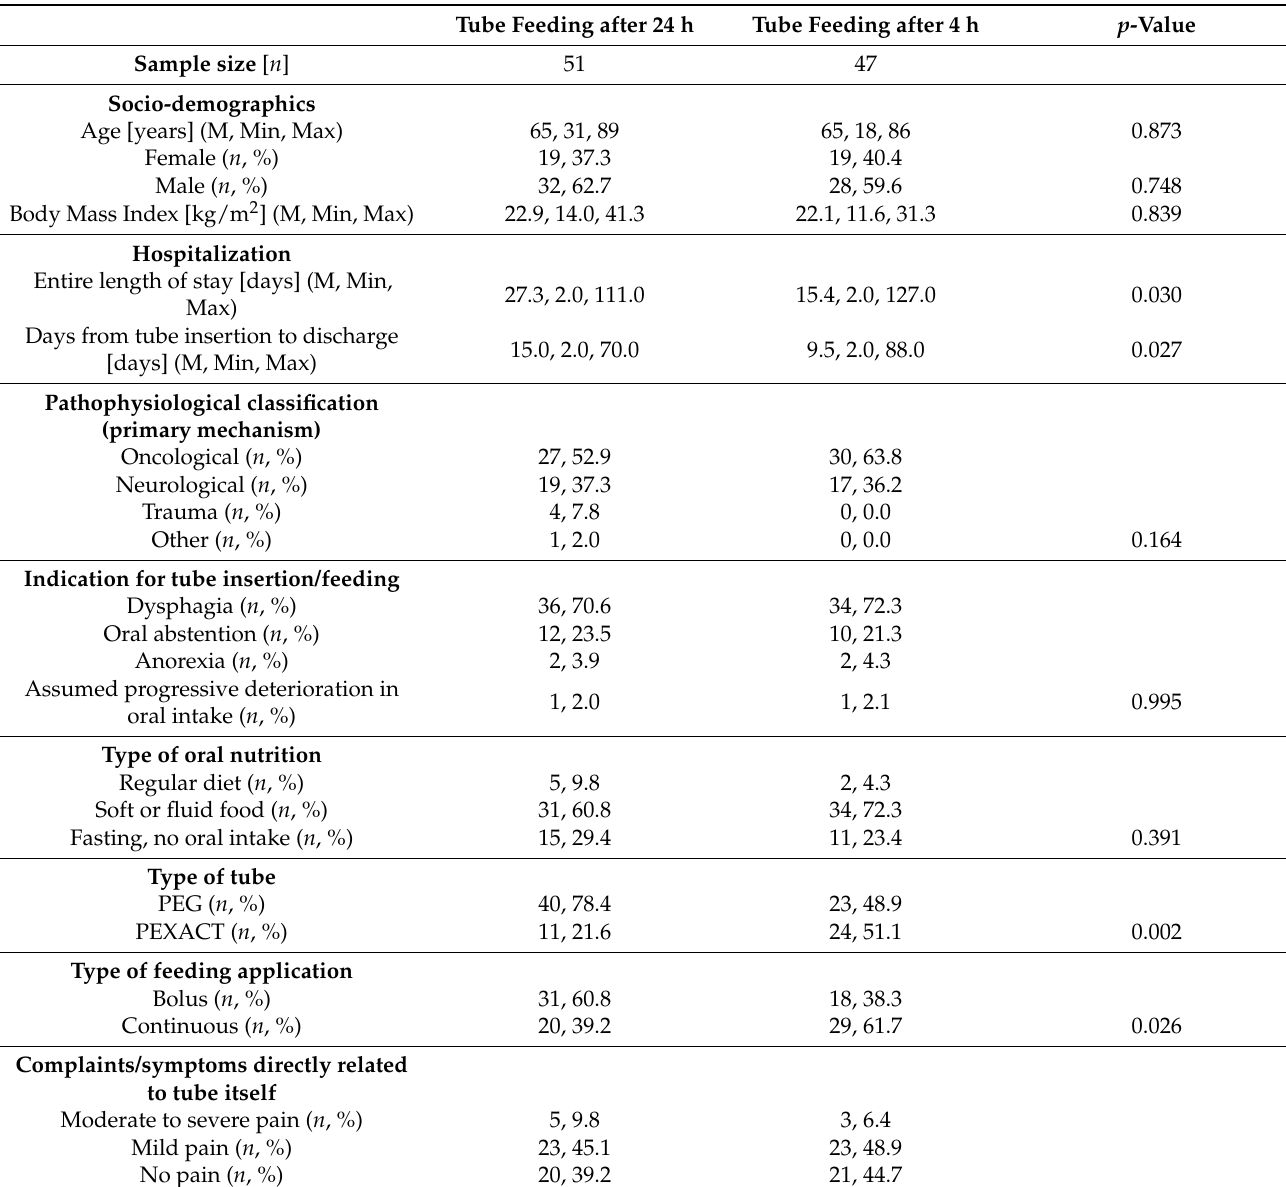
Table 1. Sample characteristics and results of the statistical comparison ( N =